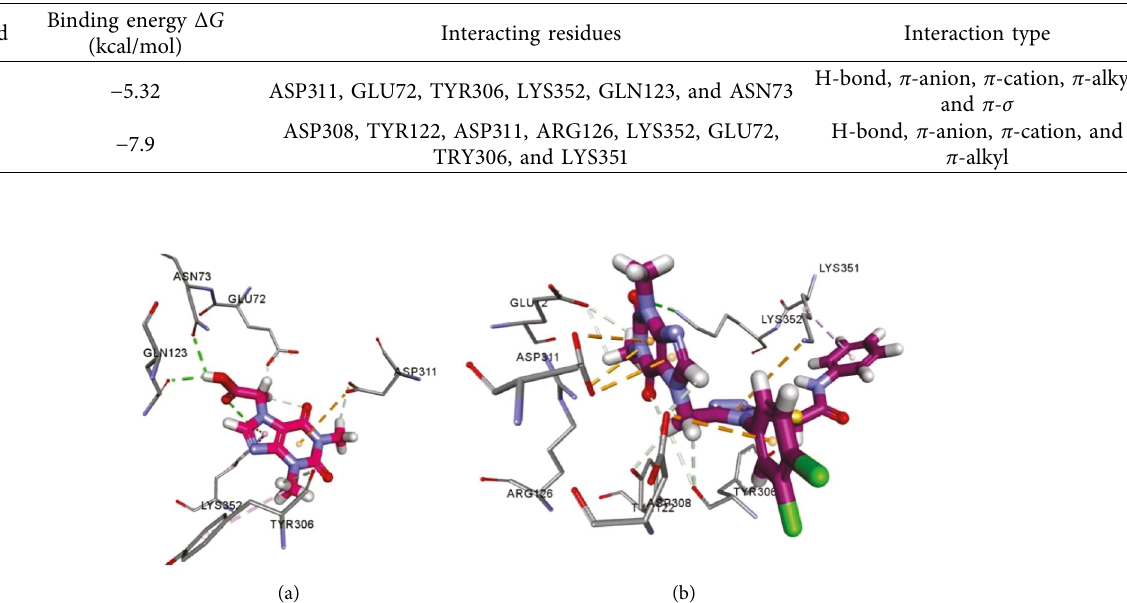
Figure 3: Conformational analysis of compounds docked using STAT3 hotspot; simulated best binding mode of (a) 2 and (b) 9e at binding